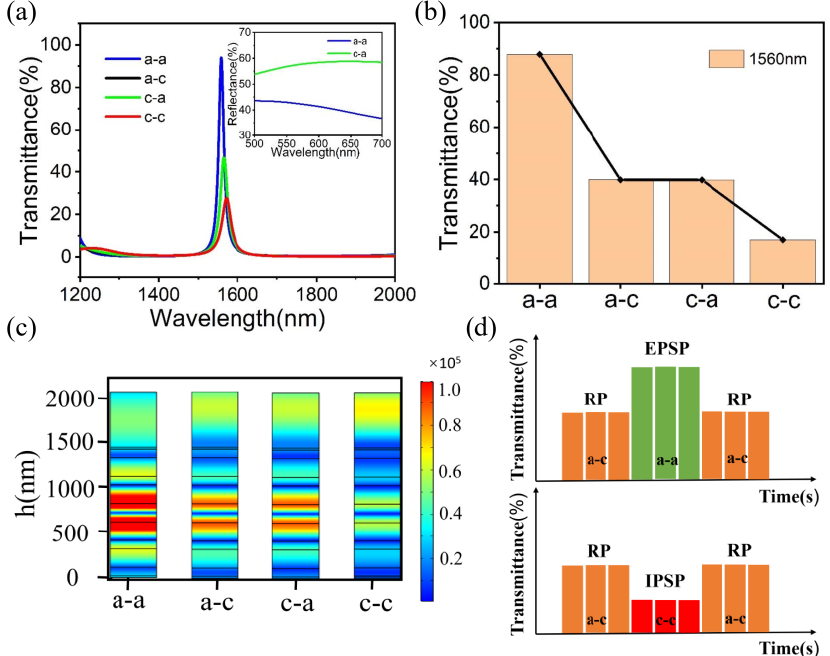
Figure 5. ( a ) Spectral distribution of the photonic synapse. ( b ) The transmittance of photonic synapse at λ = 1560 nm. ( c ) Electric field distribution of photonic synapse. ( d ) IPSP and EPSP of the photonic synapse.